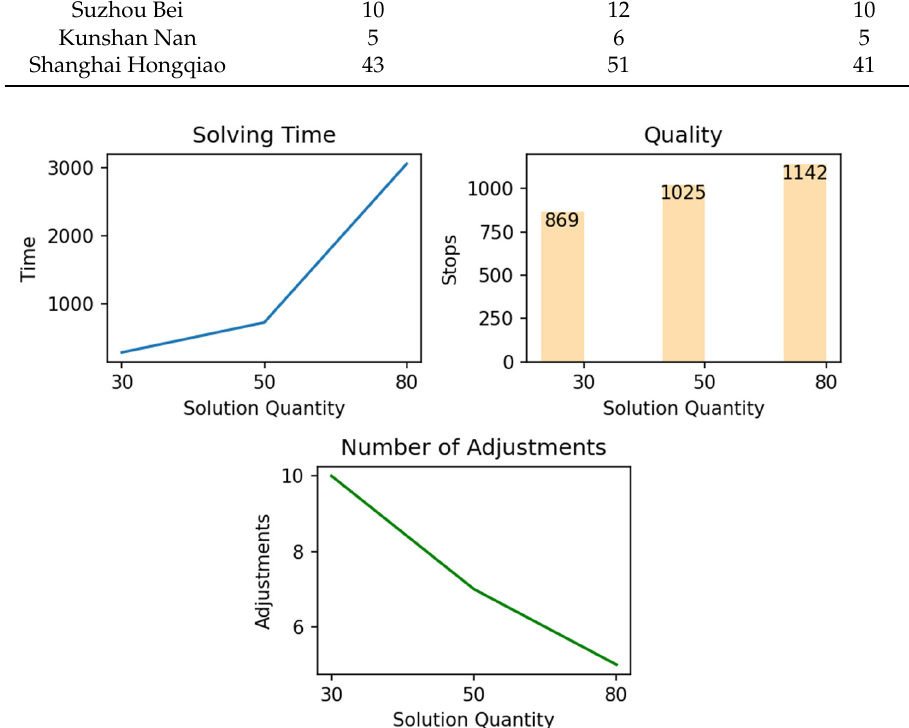
Figure 16. The result comparison of three cases.